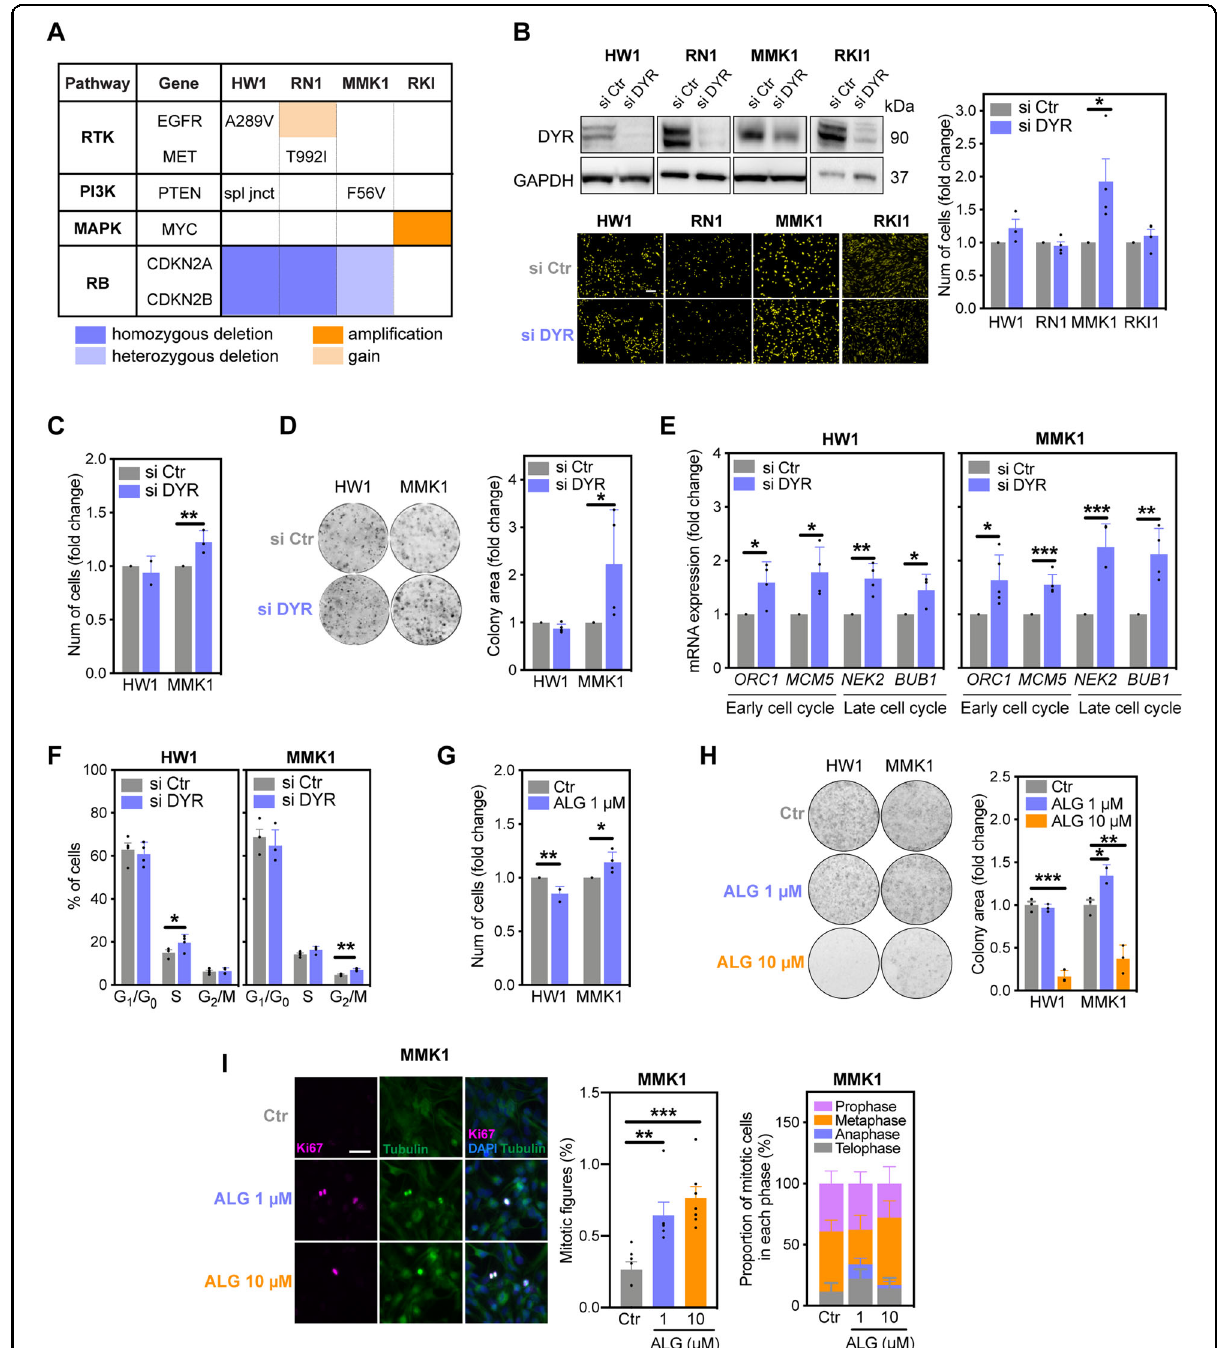
Fig. 5 DYRK1A inhibition regulates proliferation in a cell-dependent manner. A Genomic pro fi les of glioblastoma stem cell lines HW1, RN1, MMK1 and RKI. B Immunoblot analysis (72 h) and nuclear staining quanti fi cation (7 days) of cells transfected with scramble (si Ctr) and DYRK1A- targeting (si DYR) siRNAs. Scale bar: 10 μ m. C Manual counting of cells transfected with si Ctr and si DYR for 7 days. D Representative images and quanti fi cation of colonies in cells transfected with si Ctr and si DYR for 14 days. E RT-PCR analysis of cell cycle genes in cells transfected with si Ctr and si DYR for 7 days. F Flow cytometry quanti fi cation of cells in G1/G0, S and G 2 /M phases following transfection with si Ctr and si DYR for 3 days. G Nuclear staining quanti fi cation of cells treated with DYRK1A inhibitor ALGERNON (ALG) for 7 days. H Representative images and quanti fi cation of colonies in cells treated with ALG for 14 days. I Immuno fl uorescence images and quanti fi cation of mitotic fi gures in cells treated with ALG for 7 days. Cells were stained using antibodies against Ki67 (pink) and tubulin (green). DAPI was used to visualize cell nuclei (blue). Scale bar: 5 μ m. All bar graphs represent mean ± SEM from at least three independent experiments (two-tailed, unpaired t -test, * P < 0.05, ** P < 0.01, *** P < 0.001).